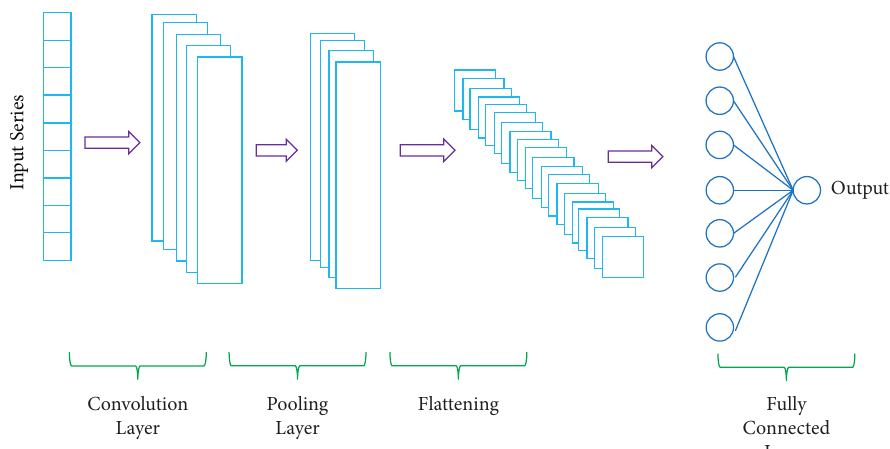
Figure 2: A simple architecture of convolutional neural network.